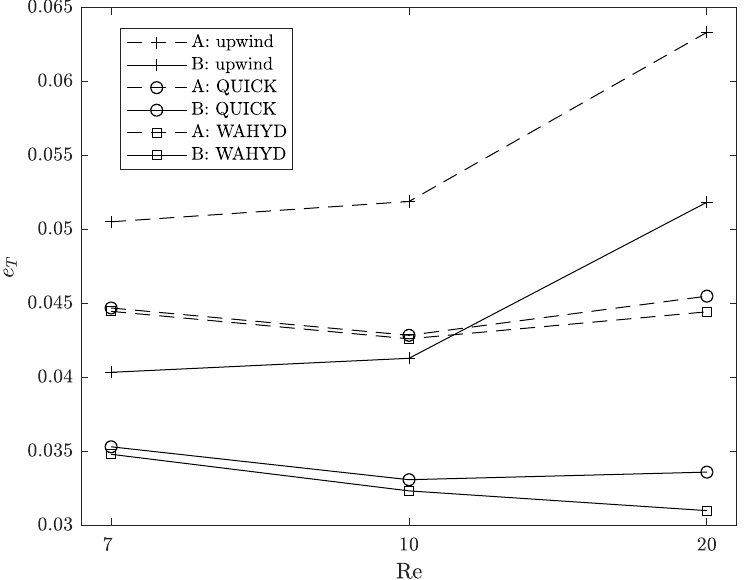
Figure 31. Total error as function of Re for the flow around a cylinder case using κ = 0.05 and the E